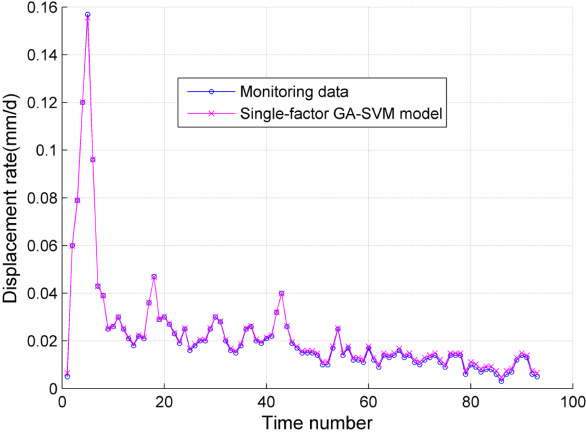
Fig. 7. The curves of the monitoring and predicting values of the displacement rate of the landslide with